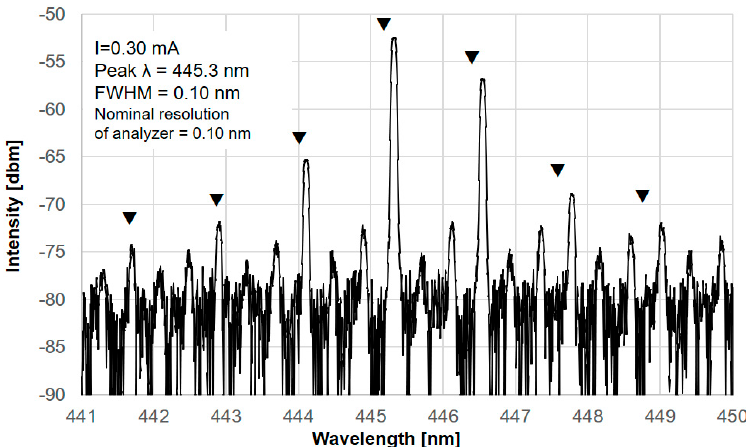
Figure 9. Emission spectrum generated by a GaN-VCSEL with a threshold current of 0.25 mA in response to a current injection of 0.30